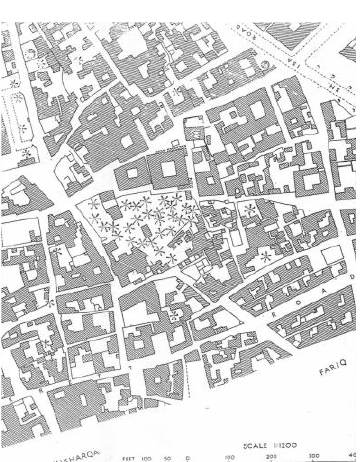
Figure 3. A portion of Manama city, Bahrain, in 1950s showing the urban fabric and spaces usage in old district. (Hamouche, 2009)